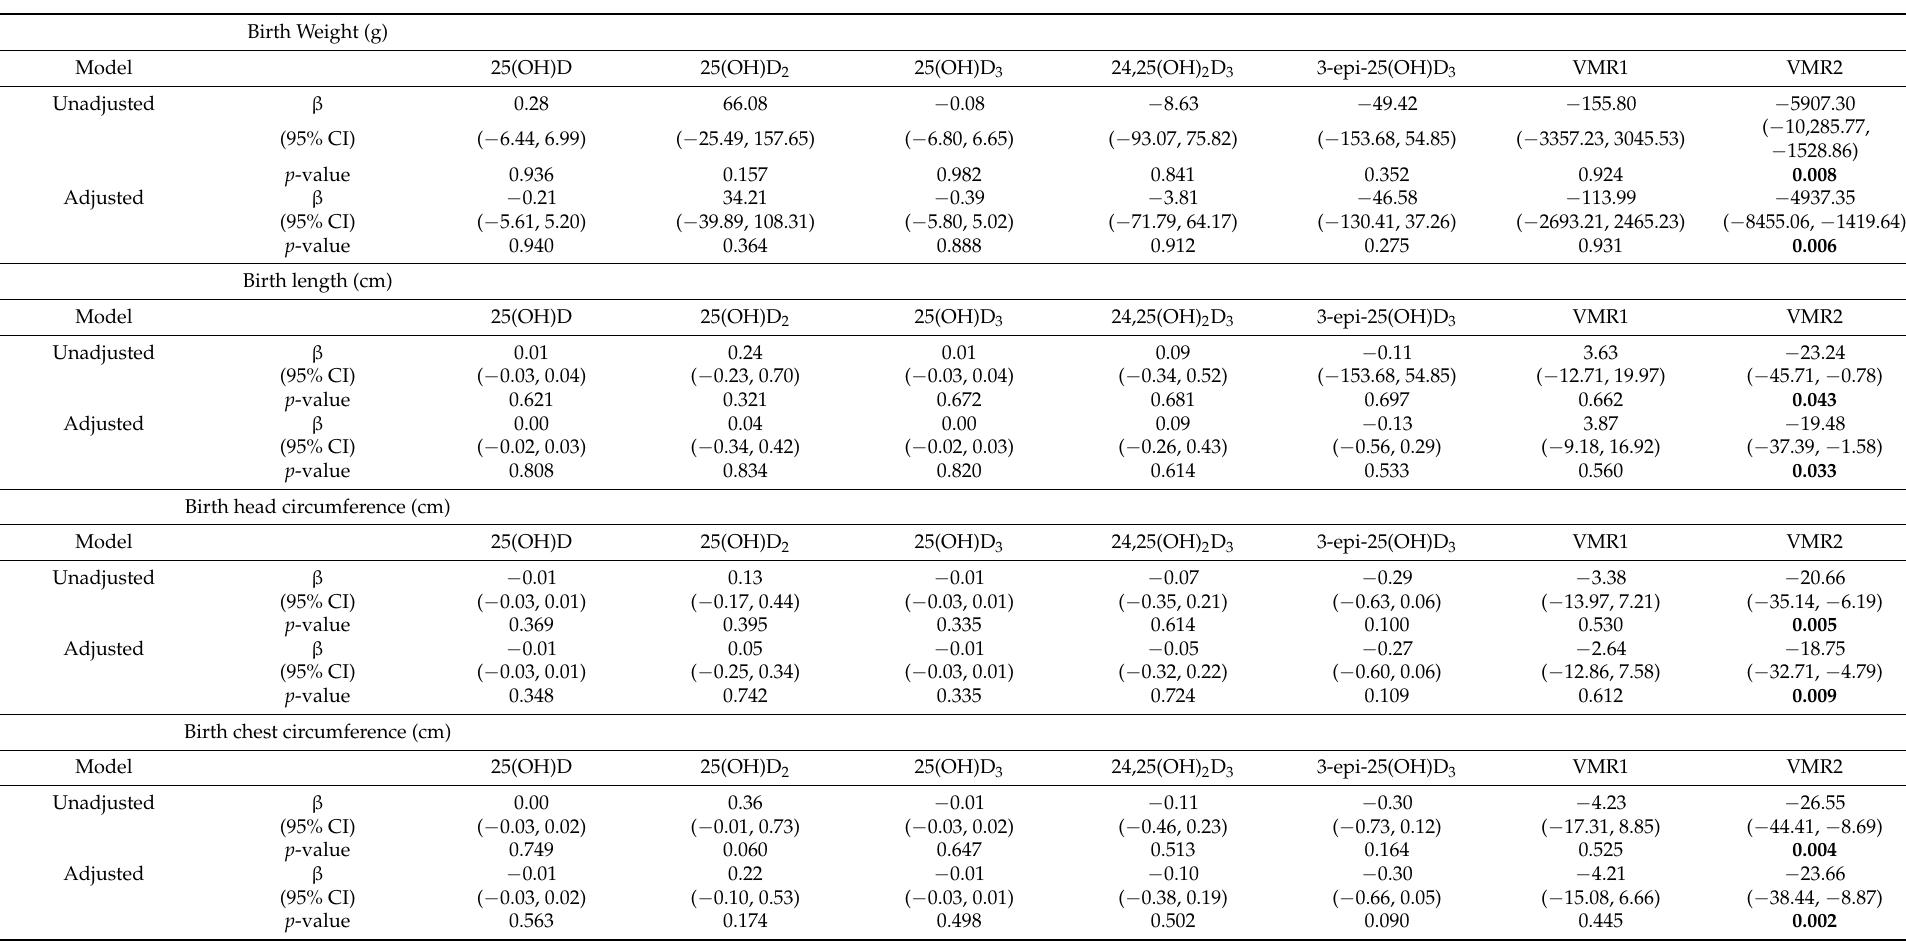
Table 4. Estimated differences (and 95% CIs) in birth anthropometrics per 1 ng/mL increase in vitamin D metabolites or 1-unit increase in